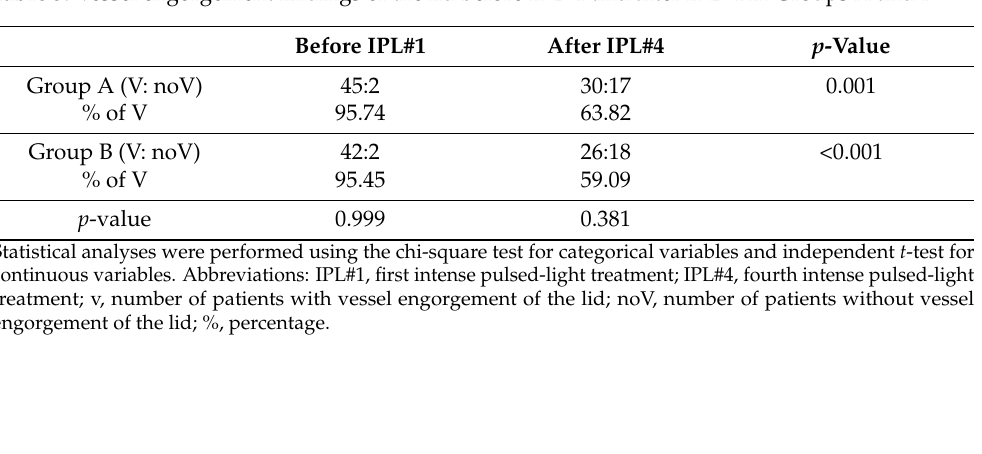
Table 5. Vessel engorgement findings of the lid before IPL#1 and after IPL#4 in Groups A and